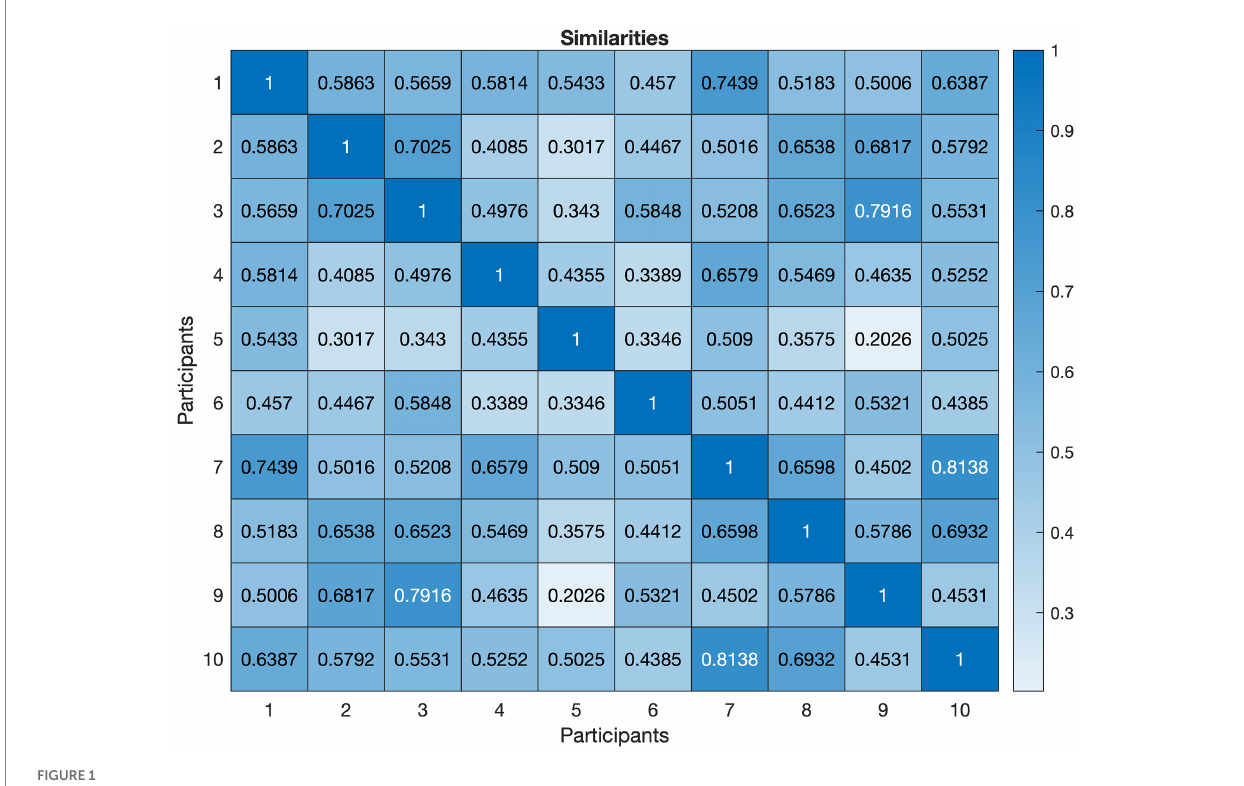
FIGURE 1 Similarity matrix for the first ten participants.